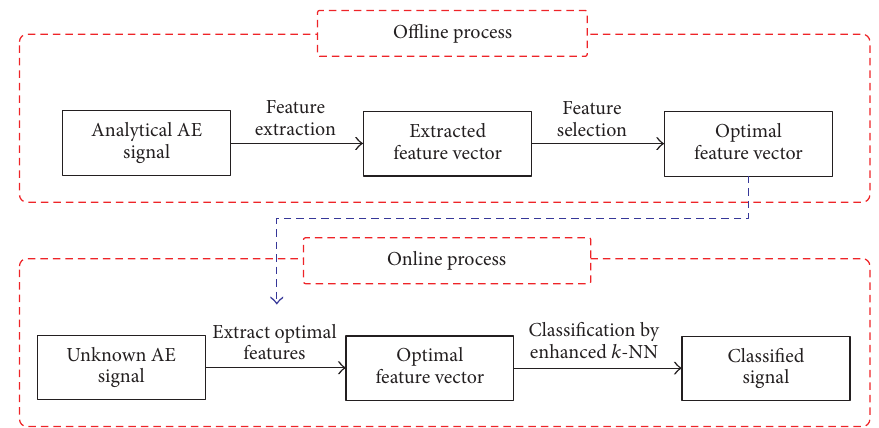
Figure 4: The proposed methodology for bearing fault diagnosis.